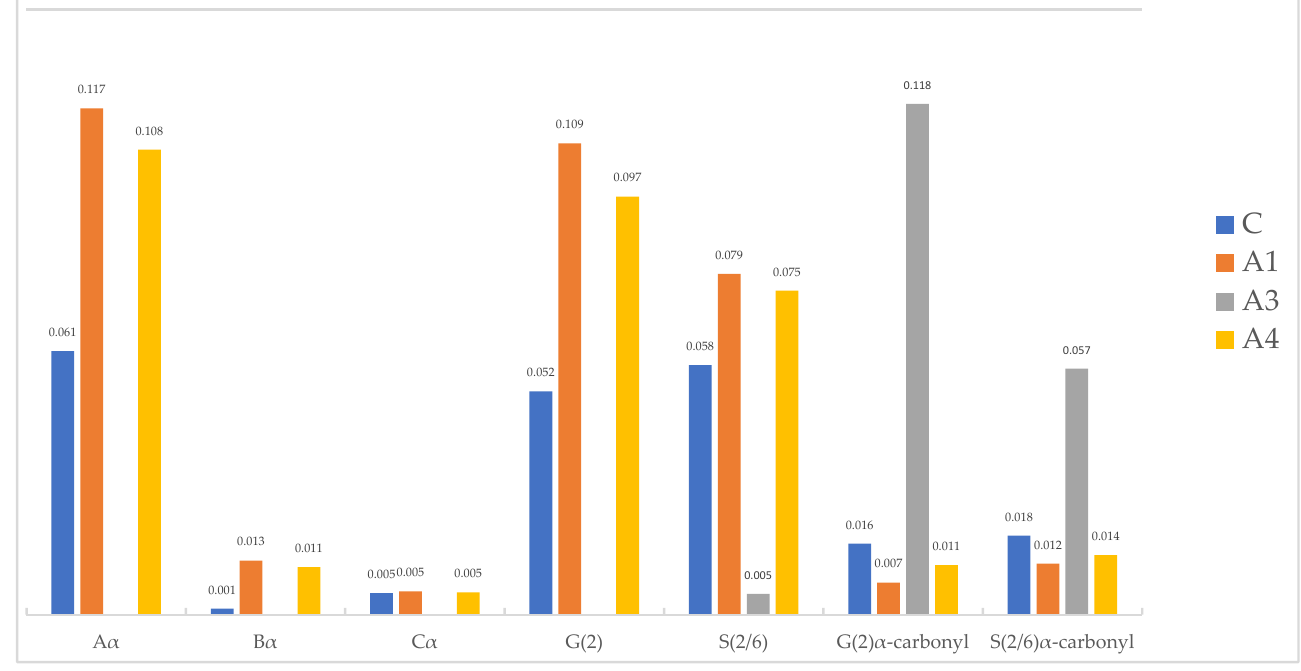
Figure 6. Bar chart summarizing the 2D NMR integrations of peaks from lignin subunits present in each spectrum of alkoxysilane-treated wood ( A1 , A3 , and A4 ) with control degraded wood ( C ). The numbers above the bars indicate the actual value of the integral. All integrations are relative to the lignin methoxyl peak.